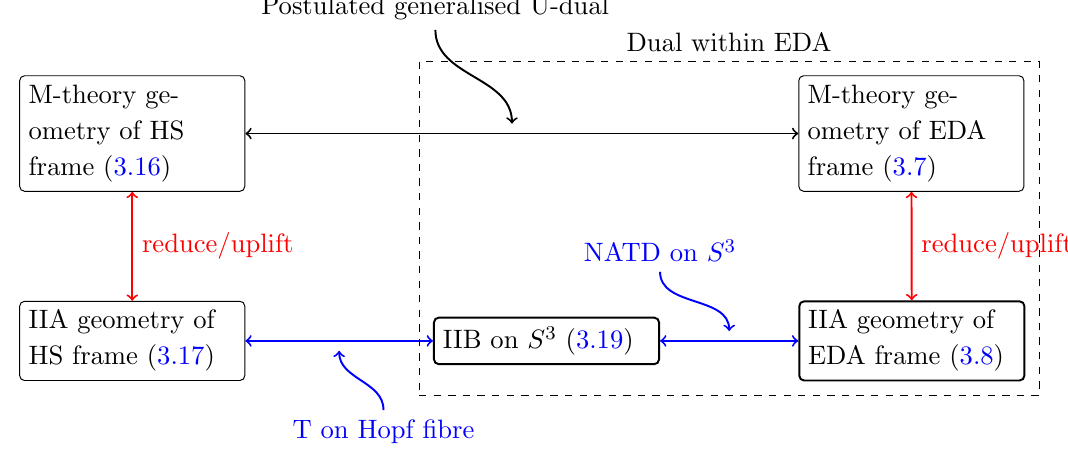
Figure 1 . Duality chains involving the NATD of S 3 and alternative CSO (3 ; 0 ; 2)